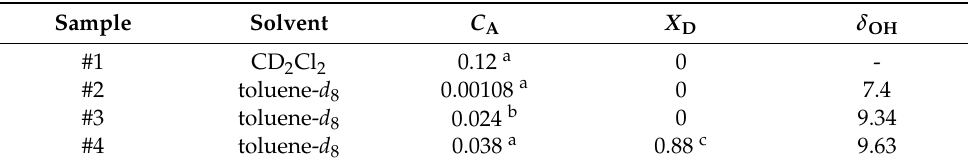
Table 1. Composition of NMR samples of TMRA